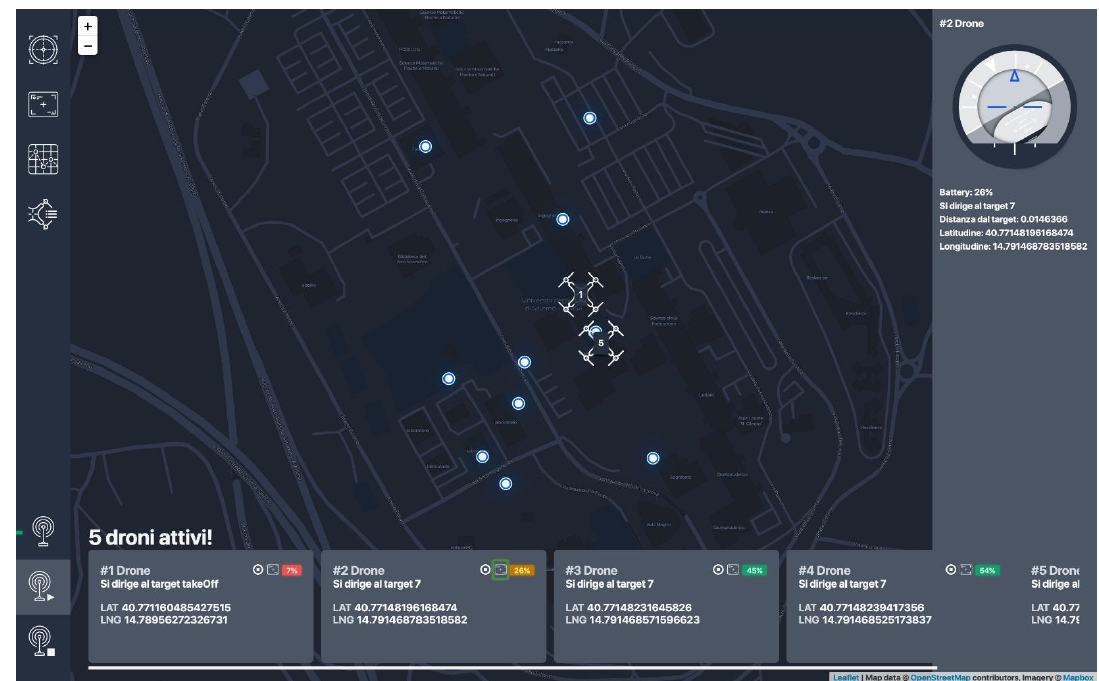
Figure 4. The GCS interface during the execution of the mission with the visualization of the artificial horizon.